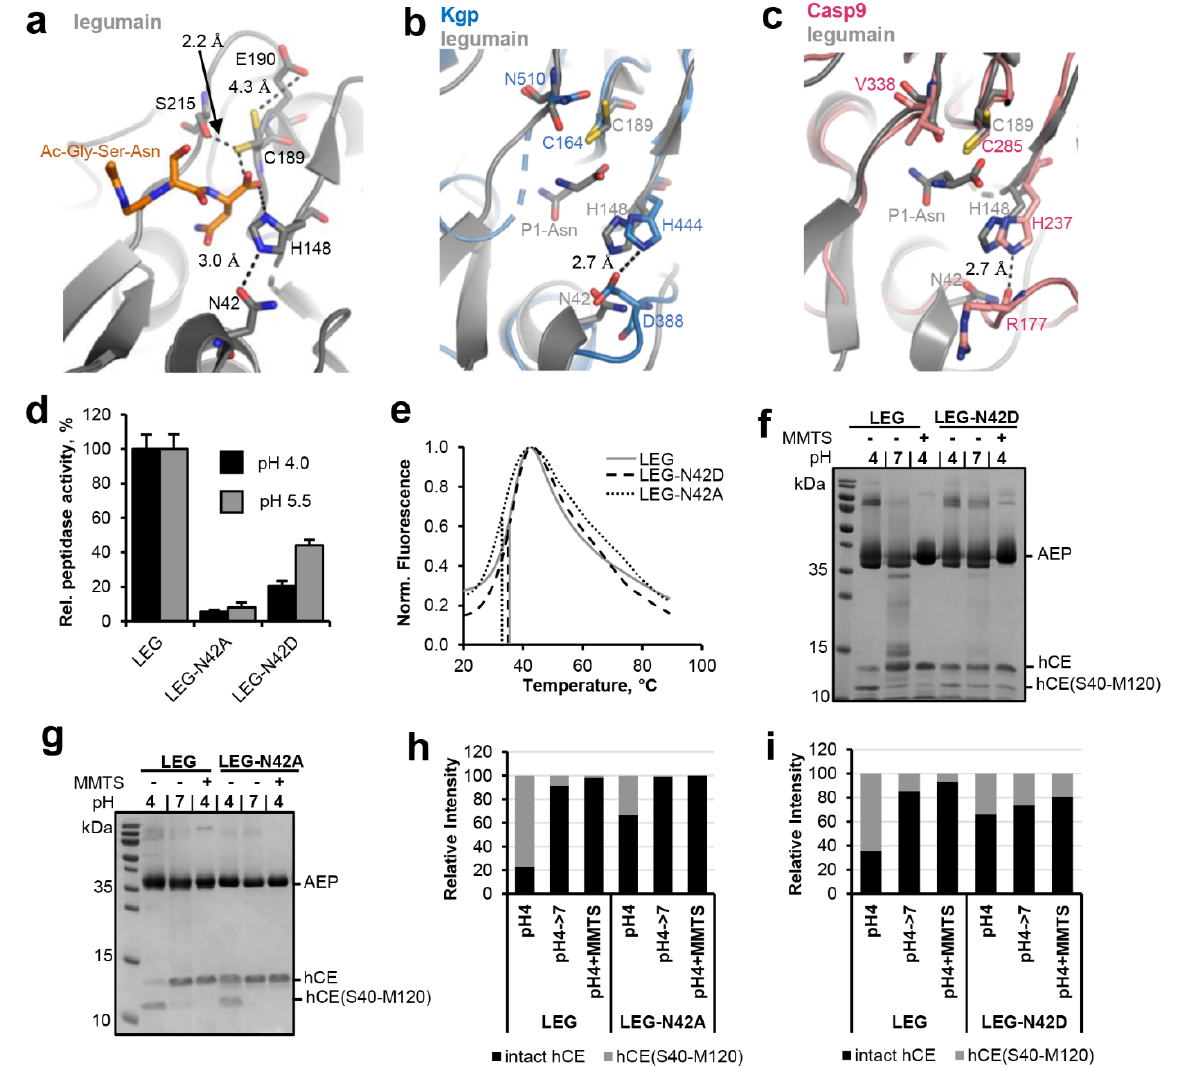
Figure 2. Asn42 enhances legumain protease activity. ( a ) Zoom-in view on the active site of legumain in complex with the Ac-Gly-Ser-Asn peptide (GSN peptide; pdb 7o50). Active site residues are shown in grey sticks, the peptide ligand in orange sticks. Please note that the side chain of Cys189 adopted two alternative conformations within this structure. ( b ) Superposition of the active sites of legumain (grey, pdb 7o50) and P. gingivalis gingipain K (blue, pdb 4rbm). ( c ) Superposition of the active site of legumain (grey) and caspase-9 (pink, pdb 1jxq). Active site residues are shown in sticks. The P1-Asn residue (grey sticks) of the GSN peptide indicates the position of the S1 specificity pocket. ( d ) Activity of wild-type, N42A- and N42D-legumain (LEG) measured as turnover of the Bz-Asn-pNA substrate at pH 4.0 and pH 5.5. ( e ) Thermal unfolding of wild-type (LEG), N42A- and N42D-legumain (LEG-N42A and LEG-N42D), measured at pH 6.0. ( f , g ) Incubation of legumain with cystatin M/E (hCE; molar ratio 3:1) at pH 4 led to processing after the P1-Asn39 residue. The C-terminal cleavage product hCE(S40-M120) is indicated. Subsequent incubation at pH 7.0 or addi- tion of S-methyl methanethiosulfonate (MMTS) led to resynthesis of the intact cystatin M/E by re- ligation of the Asn39-Ser40 peptide bond. MMTS leads to a covalent thiomethylation of the catalytic Cys189. ( h , i ) Bands corresponding to intact cystatin M/E and to the C-terminal cleavage product hCE(S40-M120) shown in ( f , g ) were quantified using ImageJ. In a next step we set out to test the relevance of Asn42 for the ligase activity of legu- main. To that end, human cystatin M/E (hCE) was used as a model substrate. In a previous study we found that cystatin M/E is processed by legumain after the P1-Asn39 residue on